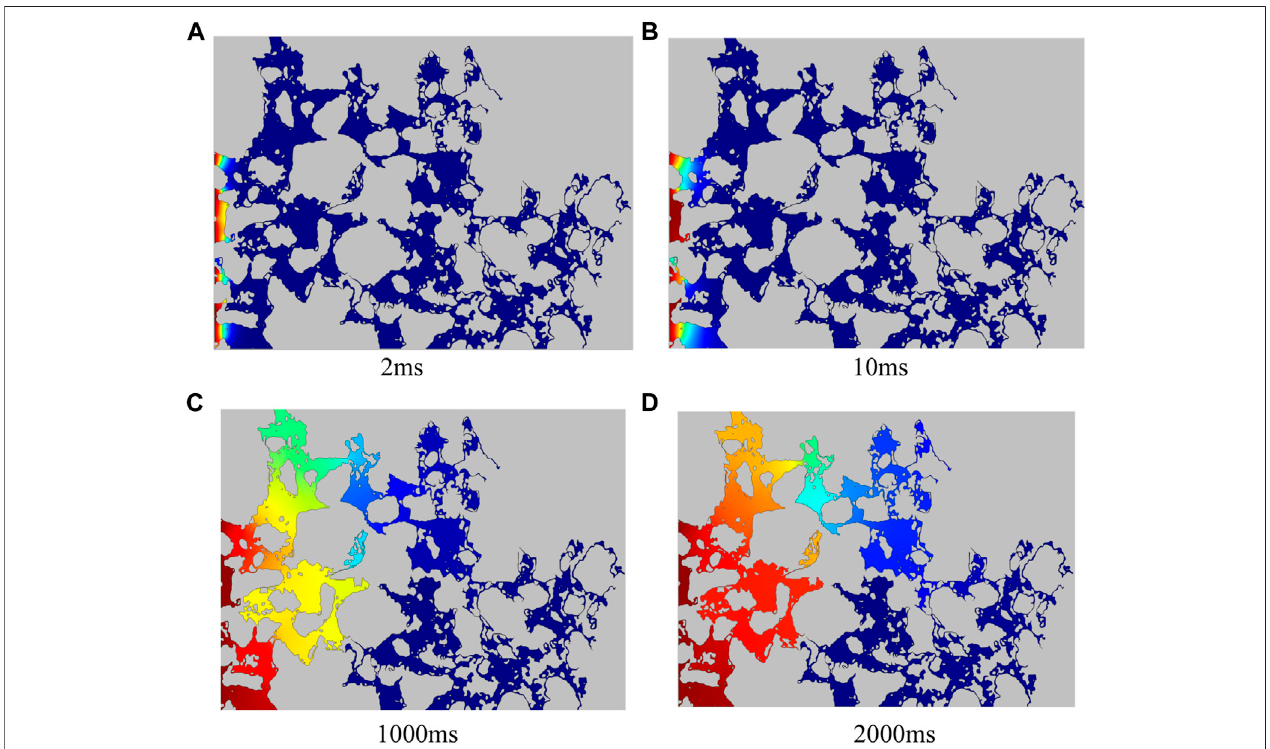
FIGURE 10 | Mass transfer process in porous media at different times. (A) 2ms, (B) 10ms, (C) 1000ms, and (D) 2000ms.